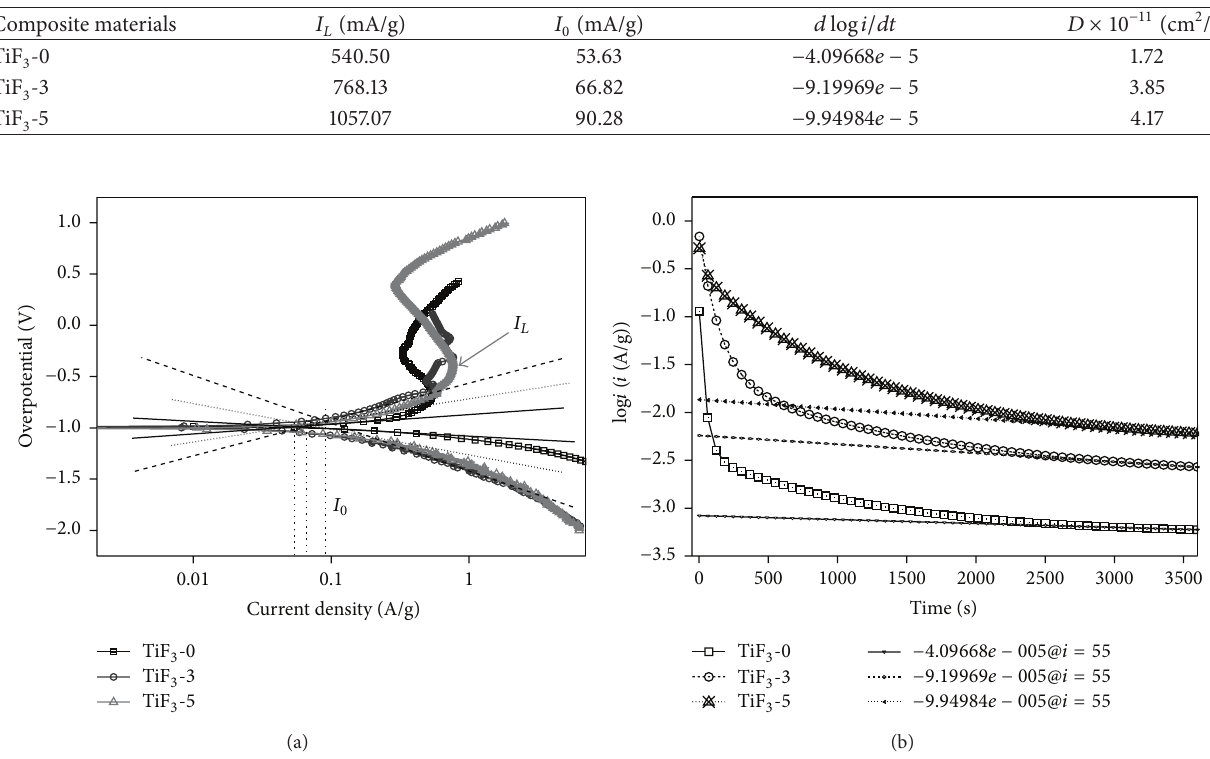
Table 2: Milled La